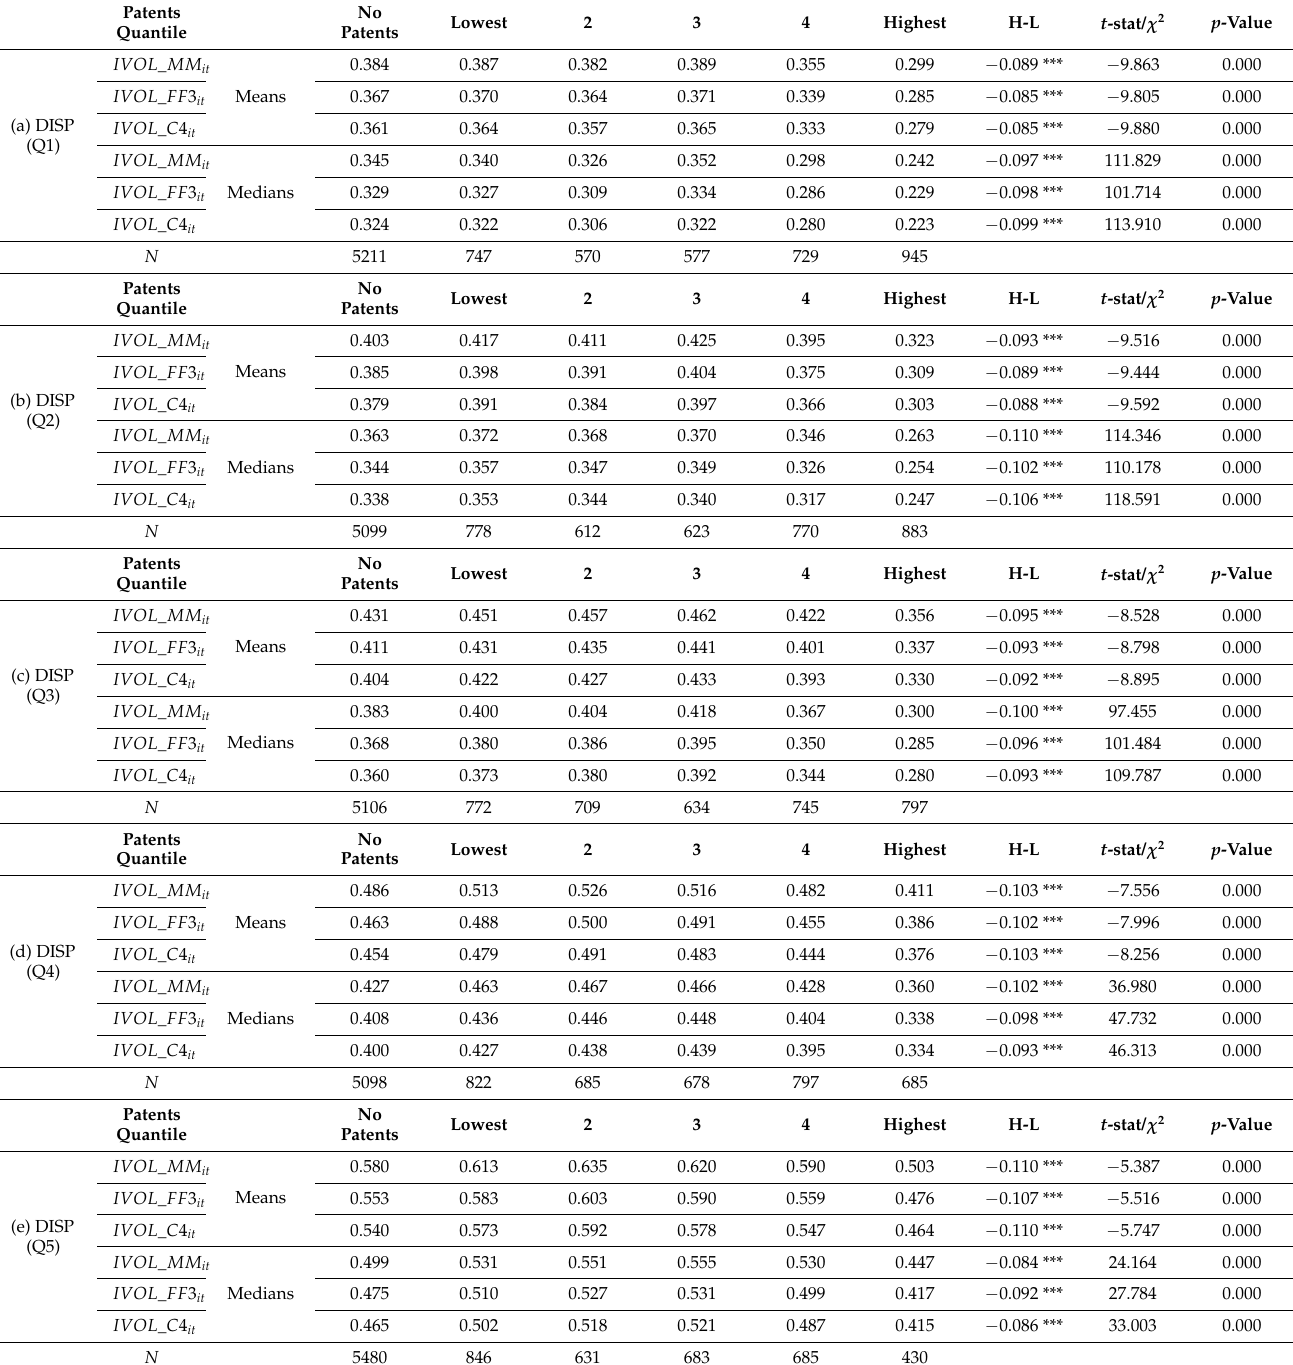
Panel B: firms grouped and sorted based on standard deviation of analyst’s forecasts and patent